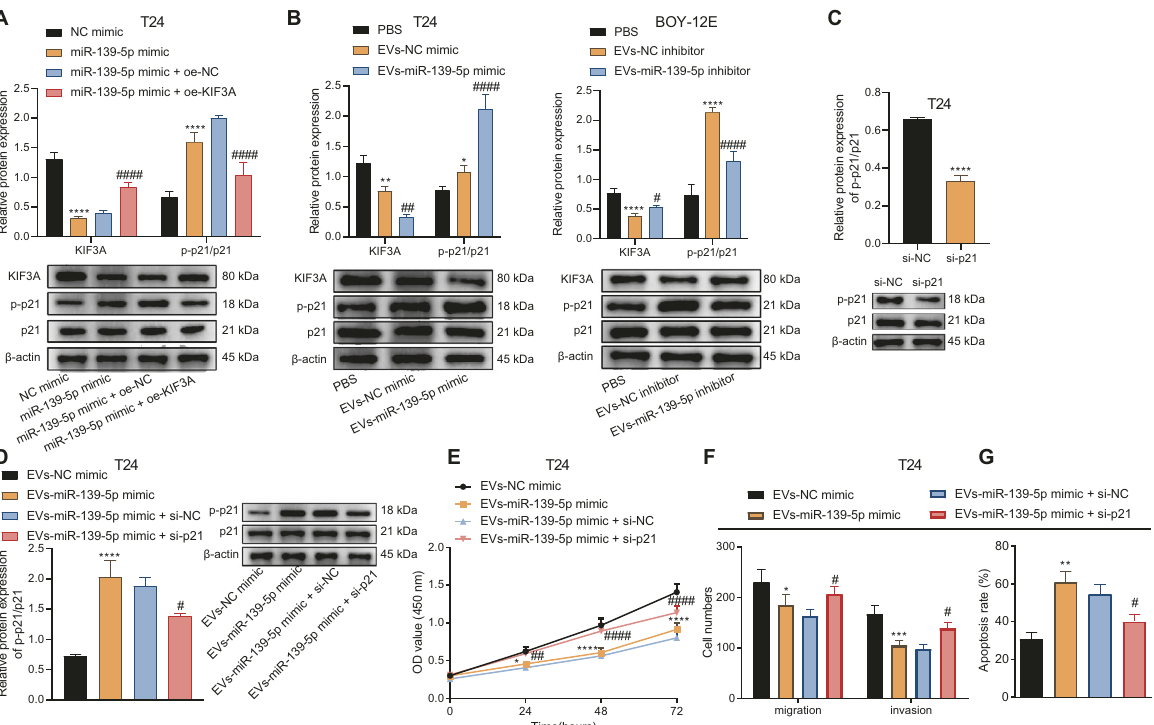
Fig. 6 miR-139-5p delivered by BMSCs-EVs downregulates KIF3A to activate p21, thus inhibiting the proliferation, migration and invasion of T24 cells while inducing their apoptosis. A The expression of KIF3A and the ratio of p-p21/p21 in T24 cells transfected with miR- 139-5p mimic or combined with oe-KIF3A detected by western blot analysis. **** p < 0.0001, vs. NC mimic. #### p < 0.0001, vs. miR-139-5p mimic + oe-NC. B The expression of KIF3A and ratio of p-p21/p21 in T24 cells co-cultured with EVs-miR-139-5p mimic and BOY-12E cells co- cultured with EVs-miR-139-5p inhibitor monitored by western blot analysis. * p < 0.05, ** p < 0.01, or **** p < 0.0001, vs. PBS. # p < 0.05, ## p < 0.01 or #### p < 0.0001, vs. EVs-NC mimic or EVs-NC inhibitor. C si-p21 transfection ef fi ciency in T24 cells detected by western blot analysis. **** p < 0.0001, vs. si-NC. D p-p21/p21 ratio in T24 cells co-cultured with EVs-miR-139-5p mimic or combined with si-p21 detected by western blot analysis. E The proliferation of T24 cells co-cultured with EVs-miR-139-5p mimic or combined with si-p21 monitored by CCK-8. F The migration and invasion of T24 cells co-cultured with EVs-miR-139-5p mimic or combined with si-p21 monitored by Transwell assay. G The apoptosis of T24 cells co-cultured with EVs-miR-139-5p mimic or combined with si-p21 monitored by Hoechst 33342/PI staining. In panels D-G, * p < 0.05, ** p < 0.01, *** p < 0.001, or **** p < 0.0001, vs. EVs-NC mimic. # p < 0.05, ## p < 0.01, or #### p < 0.0001, vs. EVs-miR-139-5p mimic + si-NC. Measurement data were expressed as mean ± standard deviation. Unpaired t test was performed for two-group data comparison. One-way ANOVA was conducted for multi-group data comparison, followed by Tukey ’ s post hoc test. The cell experiment was repeated three times